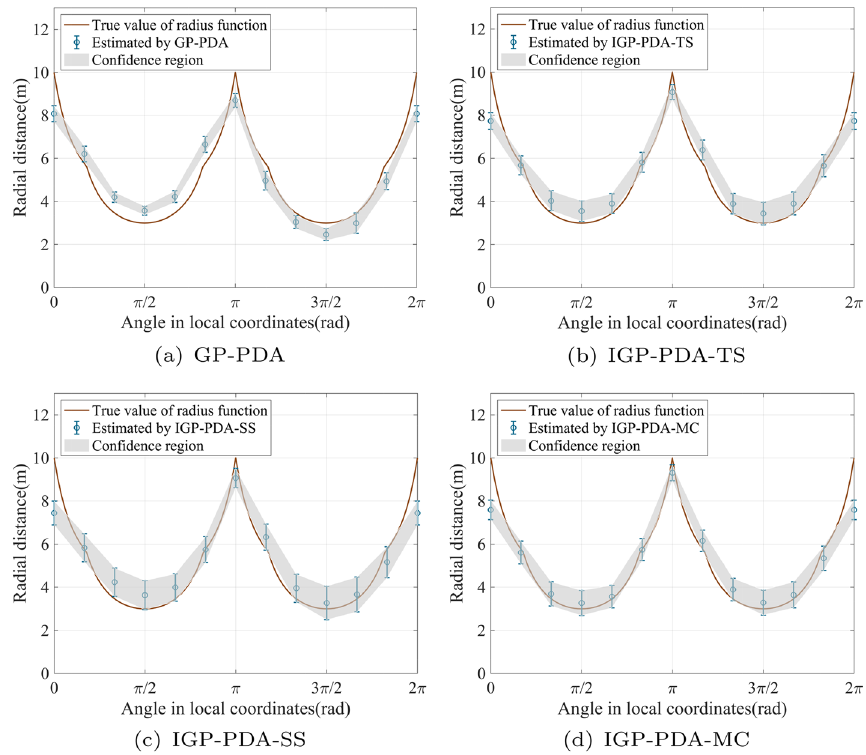
Fig. 6 True radius function and estimated error bar using different methods in the first scenario